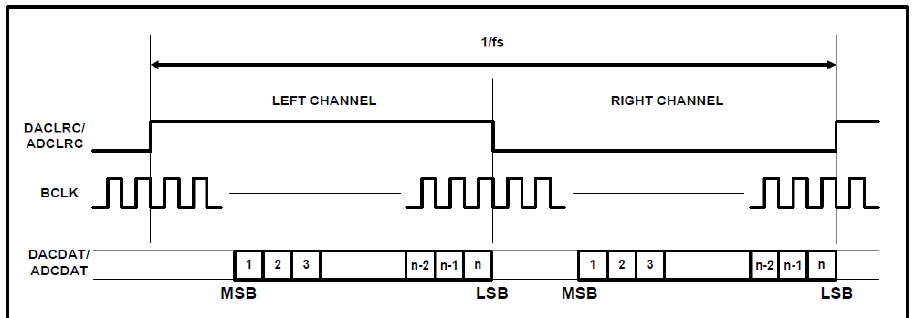
Figure 2. WM8731 chip in the right justified mode.